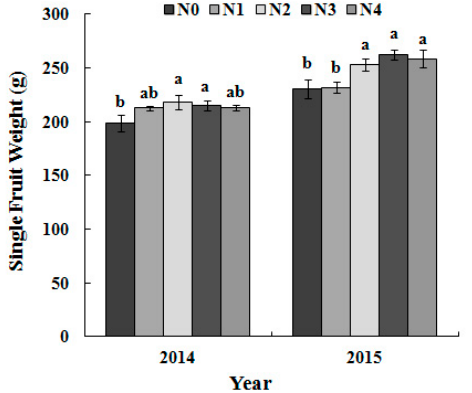
Figure 7. Single fruit weights in different N treatments.